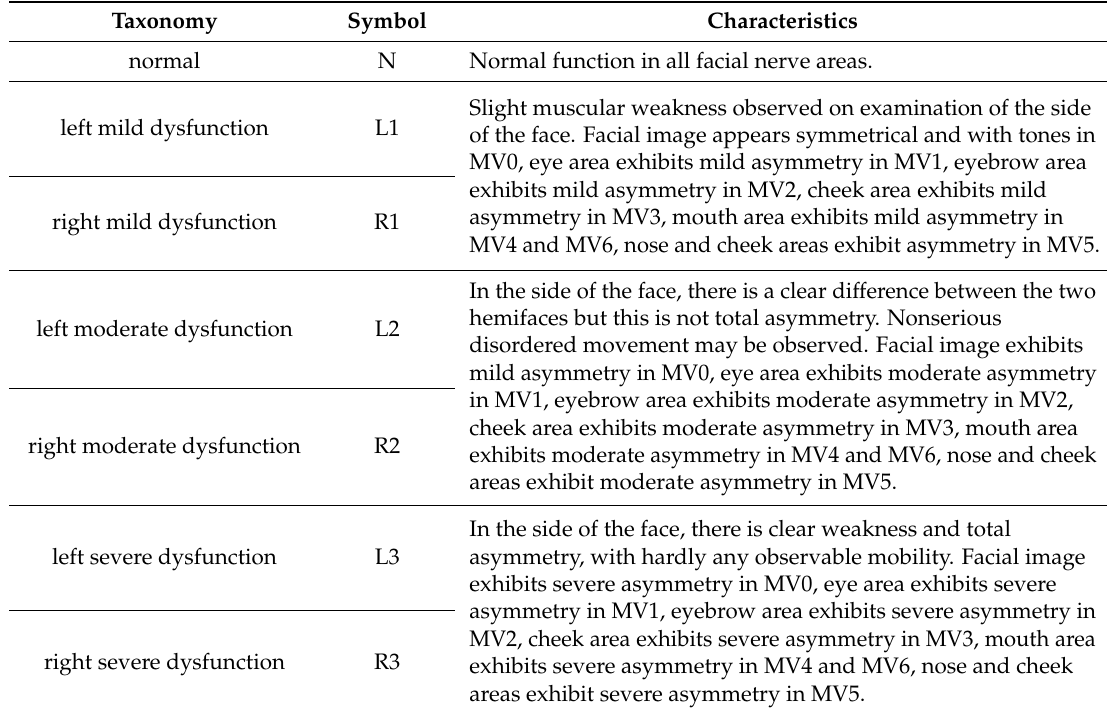
Table 3. Taxonomy characteristics.